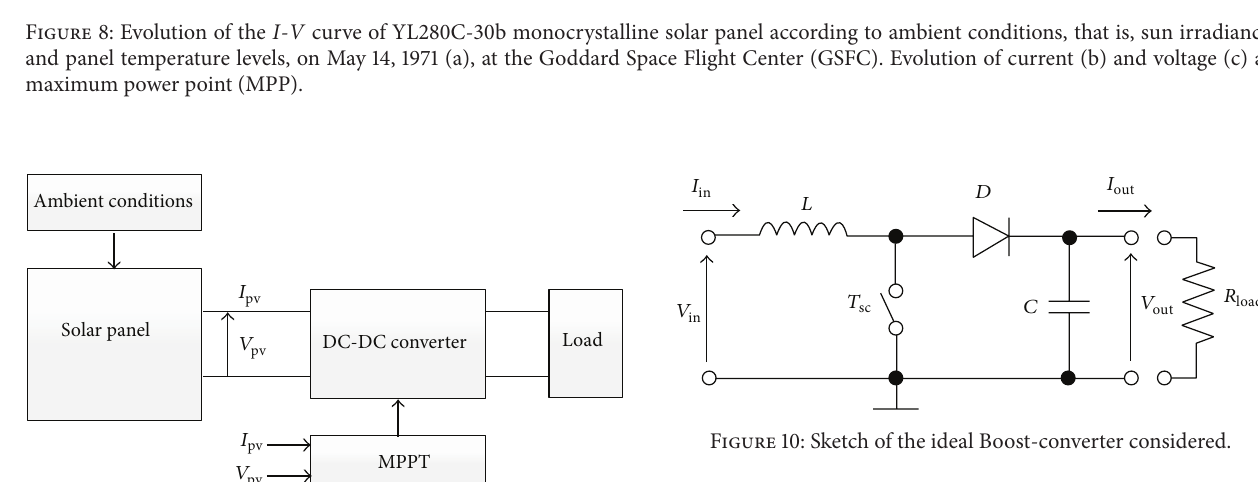
Figure 9: General scheme of a photovoltaic system formed by the solar panels, DC-DC converter controlled by an MPPT method, and load.